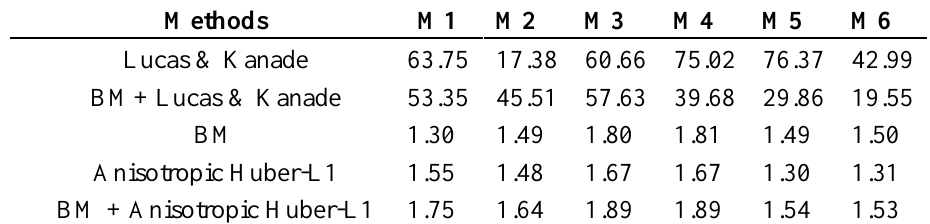
Table A3. Position Error results after being evaluated with different